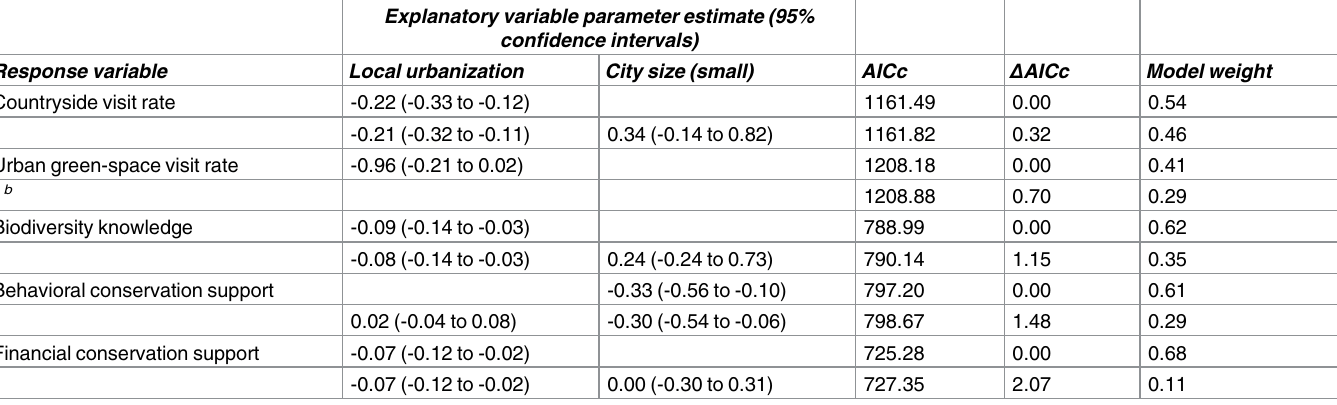
Table 4. Multiple regression models of green-space visitation rates, biodiversity knowledge, and conservation support as a function of local scale urbanization intensity and city size, without controlling for social factors (see S8 Table for equivalent models that take social factors into